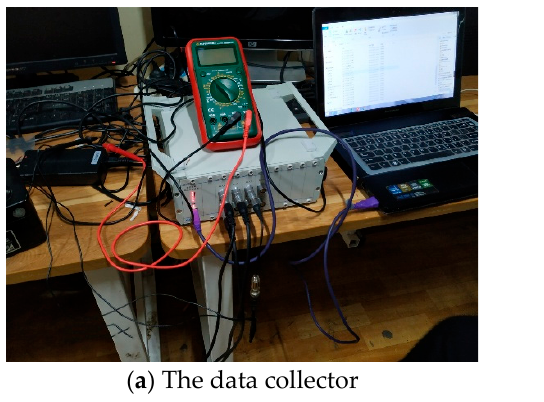
Figure 4. The test measuring equipment.